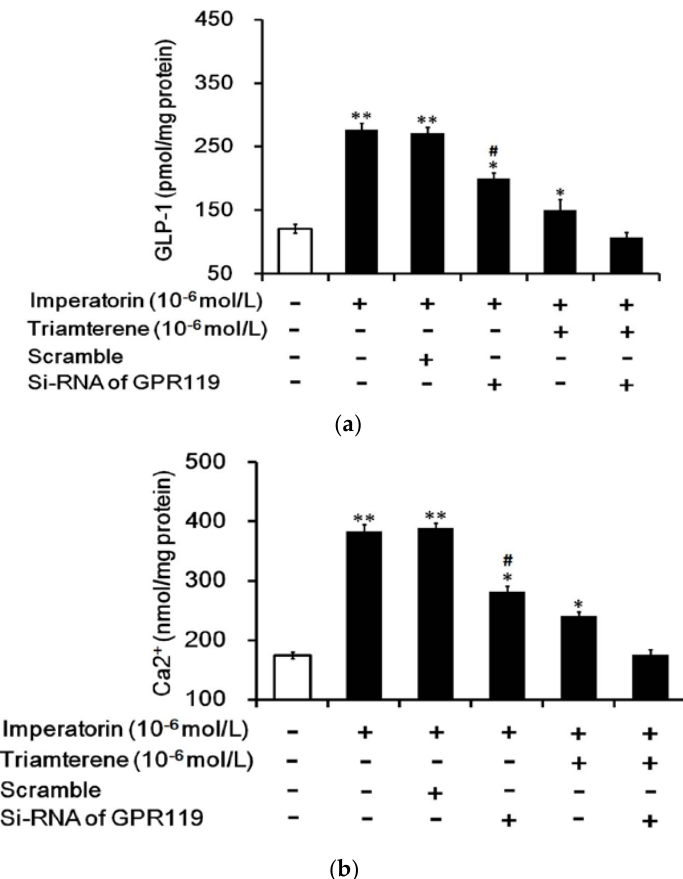
Figure 7. GPR119 is involved in increased GLP-1 secretion induced by imperatorin in NCI-H716 cells. The successful transfection of cells with GPR119 siRNA was confirmed using Western blots. ( a ) The inhibition of imperatorin-induced GLP-1 secretion by triamterene was completely abolished when GPR119 was knocked down with siRNA in NCI-H716 cells. ( b ) The increase in intracellular calcium ((Ca 2+ )i) levels was also blunted in NCI-H716 cells. The values (mean ± SEM) were obtained from eight measurements in each group. "-" in all groups are presented as 0 mol/L. "+" is present as the administration of drugs at the indicated dose. * p < 0.05 and ** p < 0.01 compared with the vehicle-treated group (first column). # p < 0.05 compared with the scrambled siRNA-treated and imperatorin-stimulated group (third column).